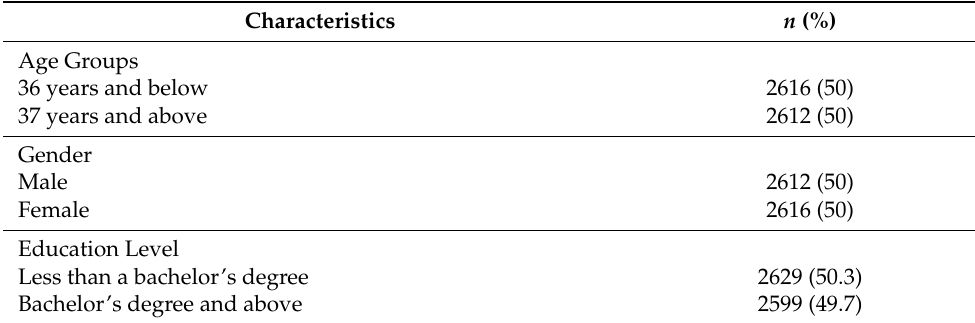
Table 1. Participants’ characteristics ( n = 5228).